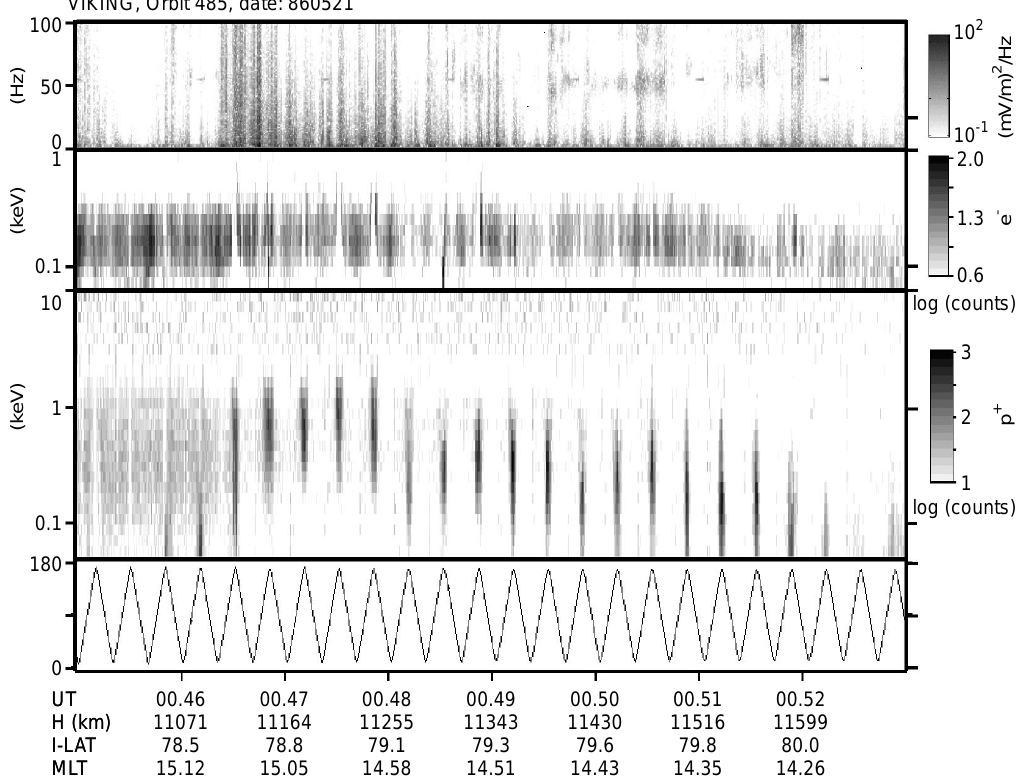
Fig. 1. The four panels show (from above): 1 , electric field spectrogram, satellite spin modulation is clearly seen; 2 , electron spectrogram; 3 , proton spectrogram; 4 , pitch angle of the particle detectors with respect to the magnetic